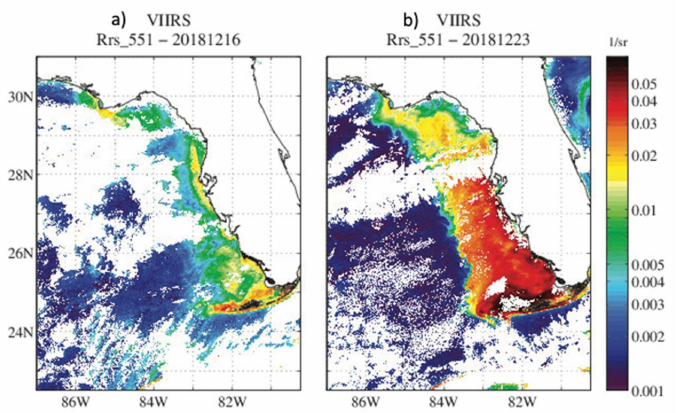
Figure 13. ( a ) Remotely-sensed reflectance at 551 nm (VIIRS) 16 December and ( b ) remotely-sensed reflectance at 551 nm (VIIRS) 23